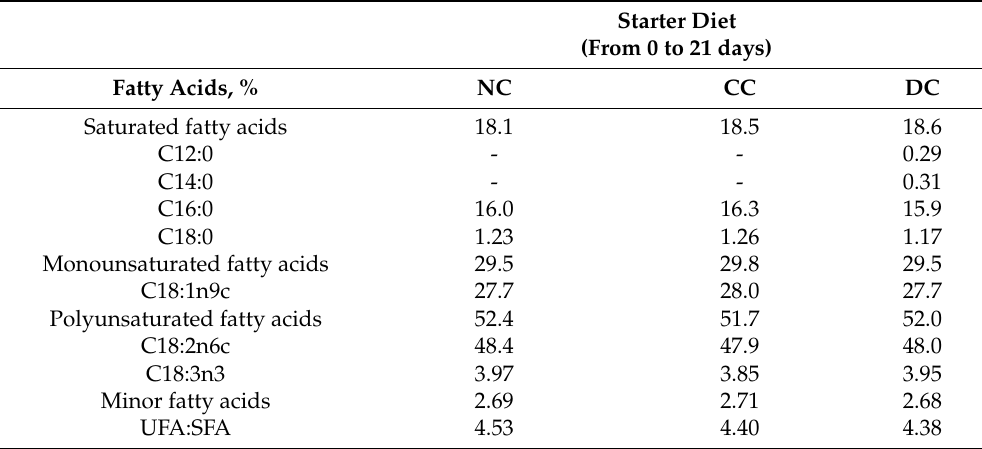
Table 7. Fatty acid compositions of the starter and grower-finisher diets 1 (Experiment